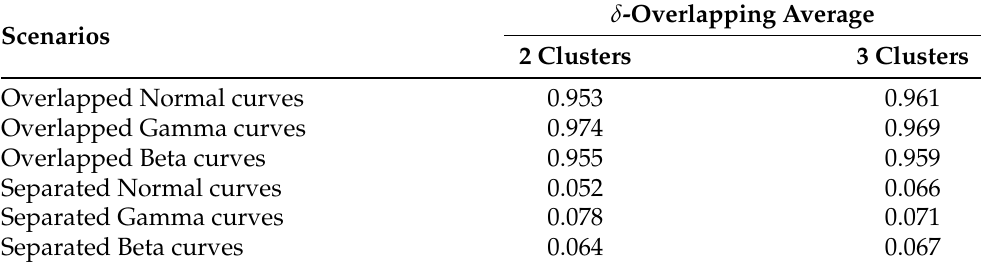
Table 2. Average value of δ in all simulation scenarios.